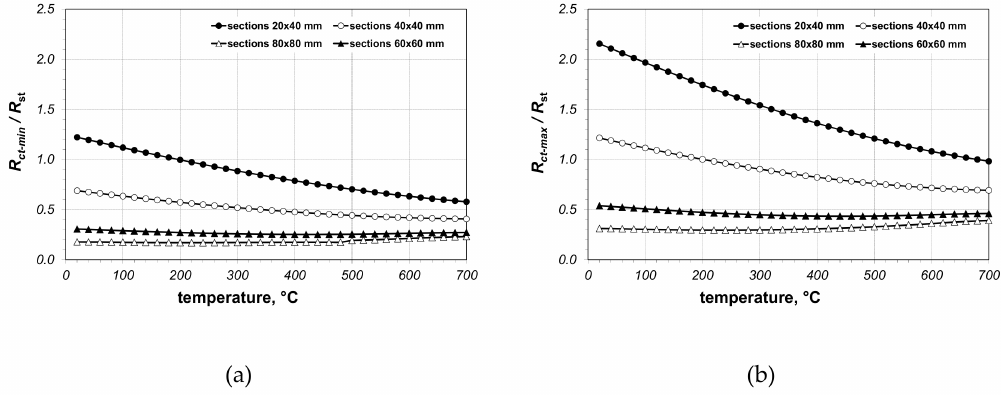
Figure 9. The results of the calculation results of the R ct / R st quotient: ( a ) values obtained for R ct -min and ( b ) values obtained for R ct -max